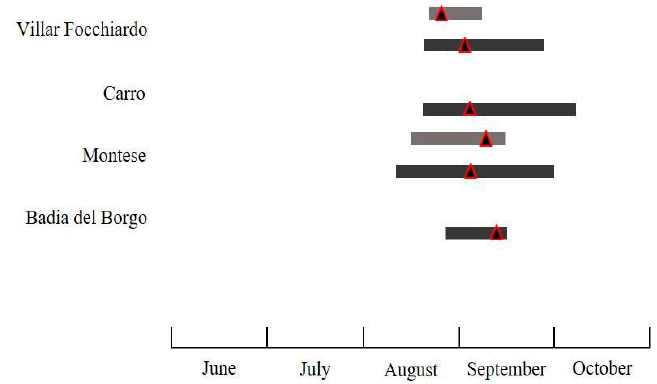
Figure 5. Seasonal flight activity of Cydia fagiglandana (Zeller) recorded in the surveyed sites using the experimental pheromone (grey bars refer to 2018, black bars to 2019. For each bar, the triangle corresponds to the population peak).